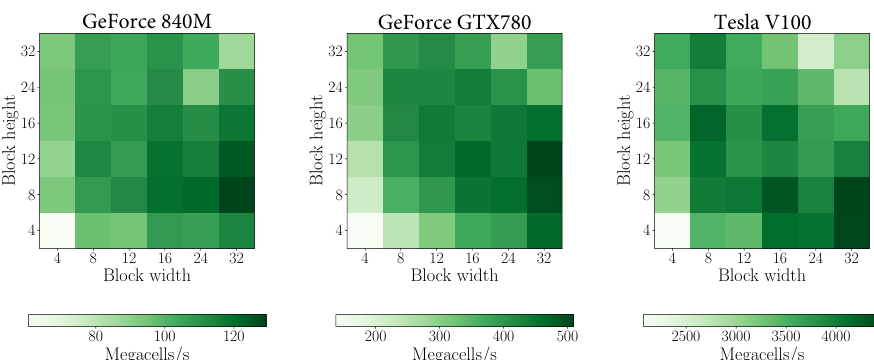
950 cells of size 400 m 400 m. The × ×